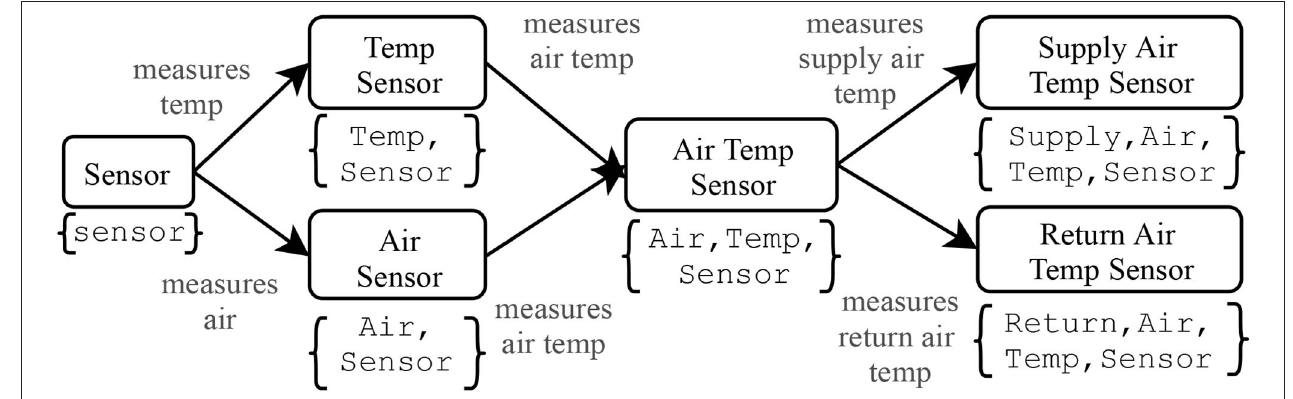
FIGURE 4 | Portion of Brick+ class lattice illustrating the equivalence between tags and classes. Edges indicate which properties are added to each concept (class) to produce a new class. Reverse edges (not pictured) are the subclass